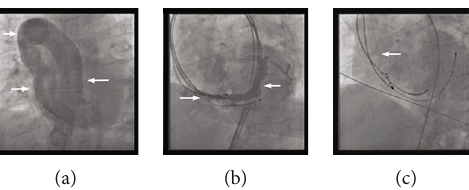
Figure 2: (a) Fluoroscopy of a dilated vena azygos (arrows) with in fl ow into the superior vena cava and the right atrium (p.a. projection). (b) Fluoroscopy of the coronary sinus (arrows), LAO 30 ° . (c) Fluoroscopy of the ablation catheter (arrow) via internal jugular vein placed in the area of the coronary sinus ostium (posteroseptal) during ablation, LAO 30 ° .